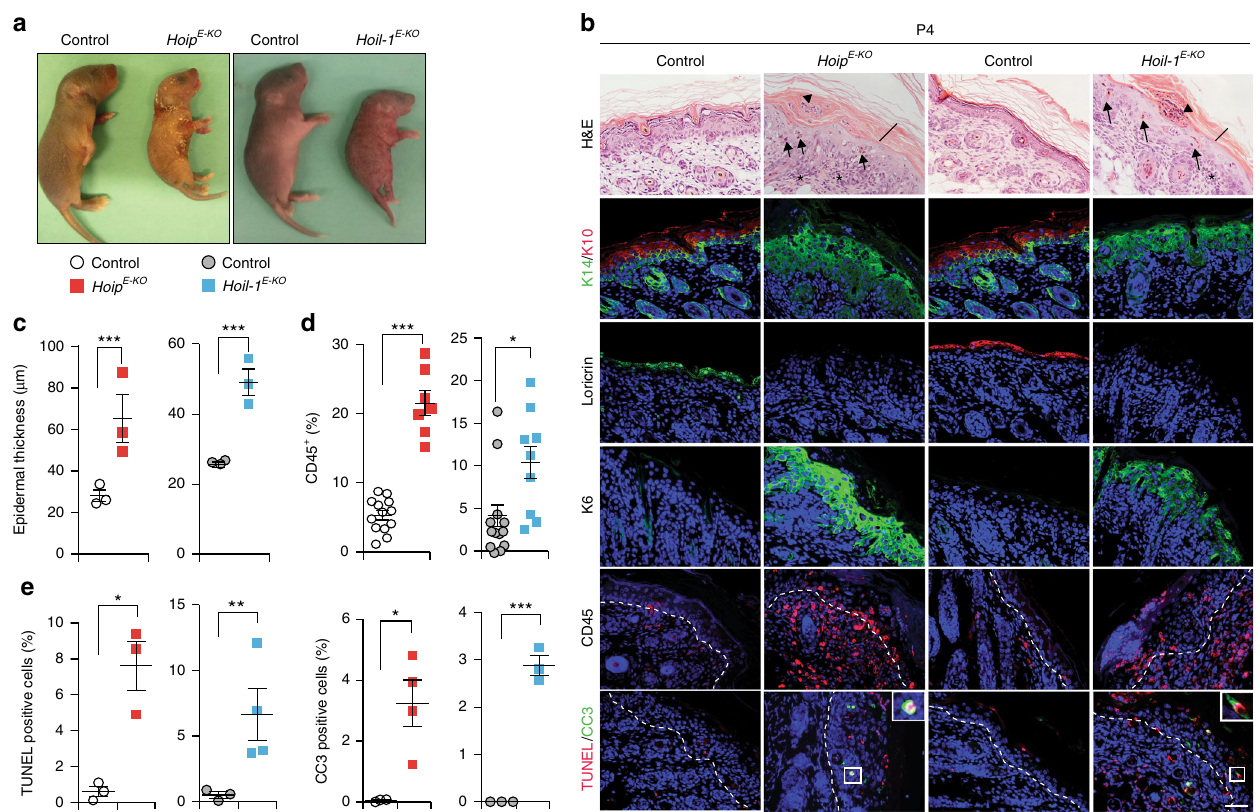
Fig. 1 Deletion of HOIP or HOIL-1 in keratinocytes results in lethal dermatitis. a Representative images of mice of the indicated genotypes ( n = 10 mice per genotype) at P4. b Representative images of skin sections stained with H&E, the indicated antibodies or TUNEL from mice of the indicated genotypes ( n = 3 mice per genotype). Arrows: pyknotic nuclei, stars: immune cell in fi ltrates, arrowhead: parakeratosis and black bar: hyperkeratosis. Nuclei were stained with DAPI (blue). White dashed lines indicate boundary of epidermis (above) and dermis (below). Scale bar, 50 µ m. c Epidermal thickness quanti fi cation at P4. Data are presented as mean values± s.e.m. ( n = 3 per genotype). *** P ≤ 0.001. d Percentages of CD45 + cells in the skin of the indicated genotypes at P4. Data are presented as mean values ± s.e.m. ( n < 8 per genotype), * P ≤ 0.05, *** P ≤ 0.001. e Quanti fi cation of TUNEL- and CC3- positive cells as represented in b . Data are presented as mean values ± s.e.m. ( n = 3 mice per genotype), * P ≤ 0.05, ** P ≤ 0.01, *** P ≤ 0.001. Control mice represent a pool of Hoip fl / fl ;K14-Cre − and Hoip fl /wt ;K14-Cre + (white circles) or Hoil-1 fl / fl ;K14-Cre − and Hoil-1 fl /wt ;K14-Cre + (grey circles). P: postnatal